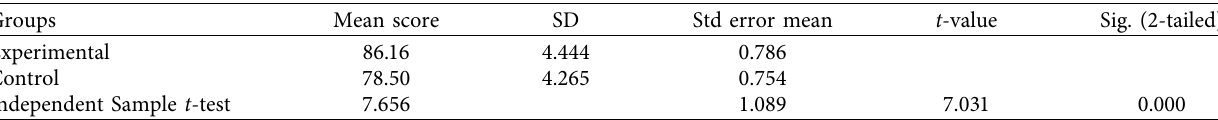
Table 4: Summary results of independent sample t -test.